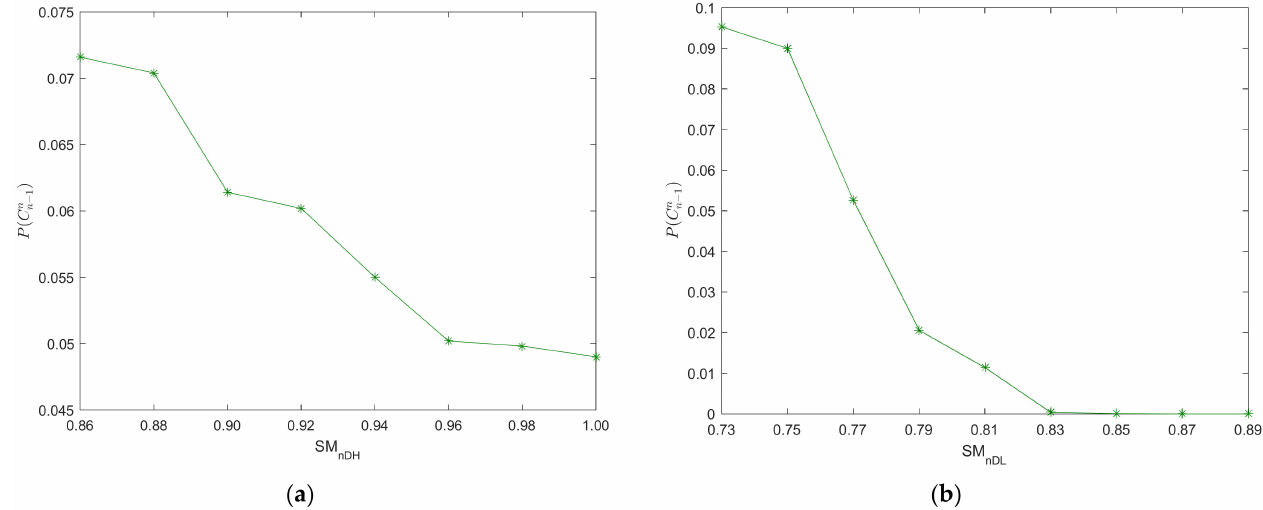
Figure 5. Varying of REC probability with the limits of the DSM, ( a ) upper limit of the DSM; ( b ) lower limit of the